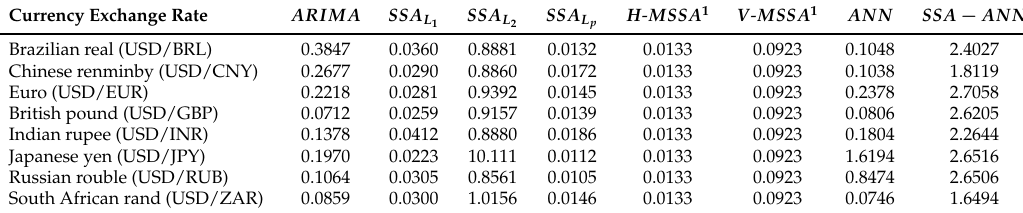
Table 6. Computational time, in minutes, for model fit, for each of the eight currency exchange rates, considering each of the eight models/algorithms, ARIMA, SSA for the window length and number of eigentriples for reconstruction as defined in Table 3, multivariate SSA for the window length and number of eigentriples for reconstruction as defined in Table 3, ANN, and the hybrid method that combines SSA and